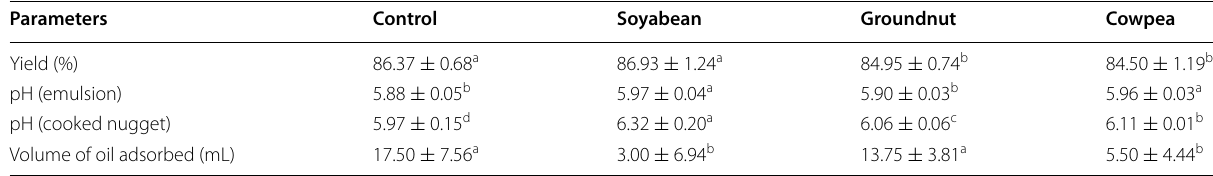
abcd Means in the same row with varying superscripts are significantly different ( P < 0.05)